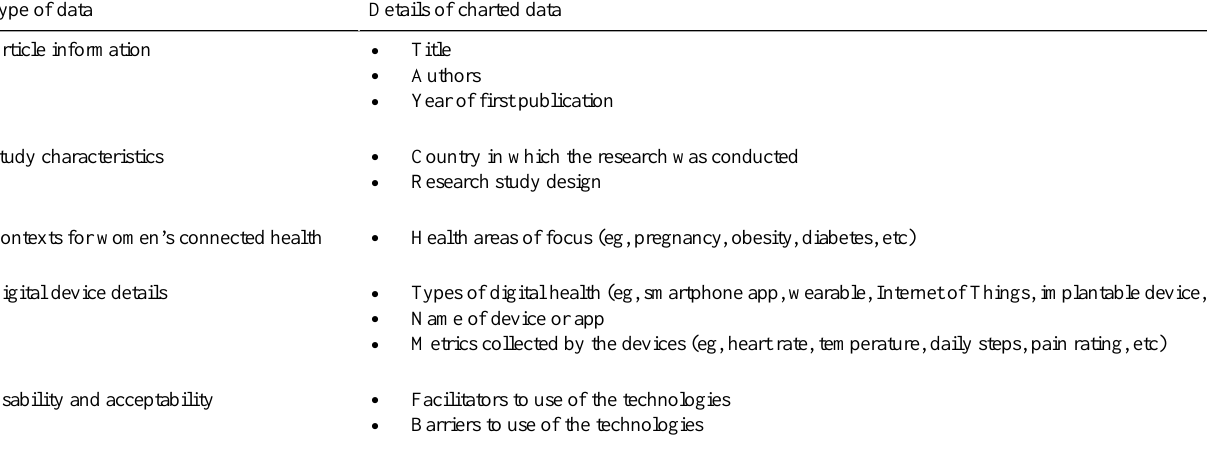
Table 1. Data charting